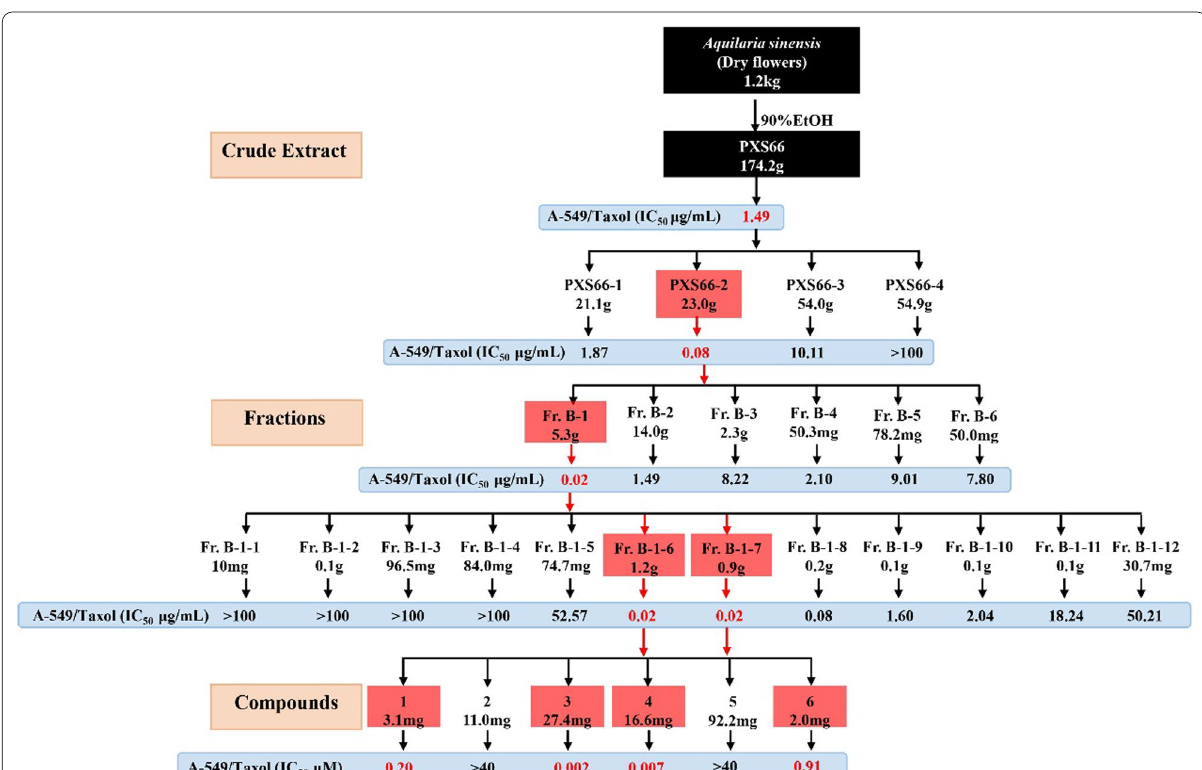
Fig. 1 Schematic diagram showing cytotoxic compounds from Aquilaria sinensis flowers by bioassay‑guided